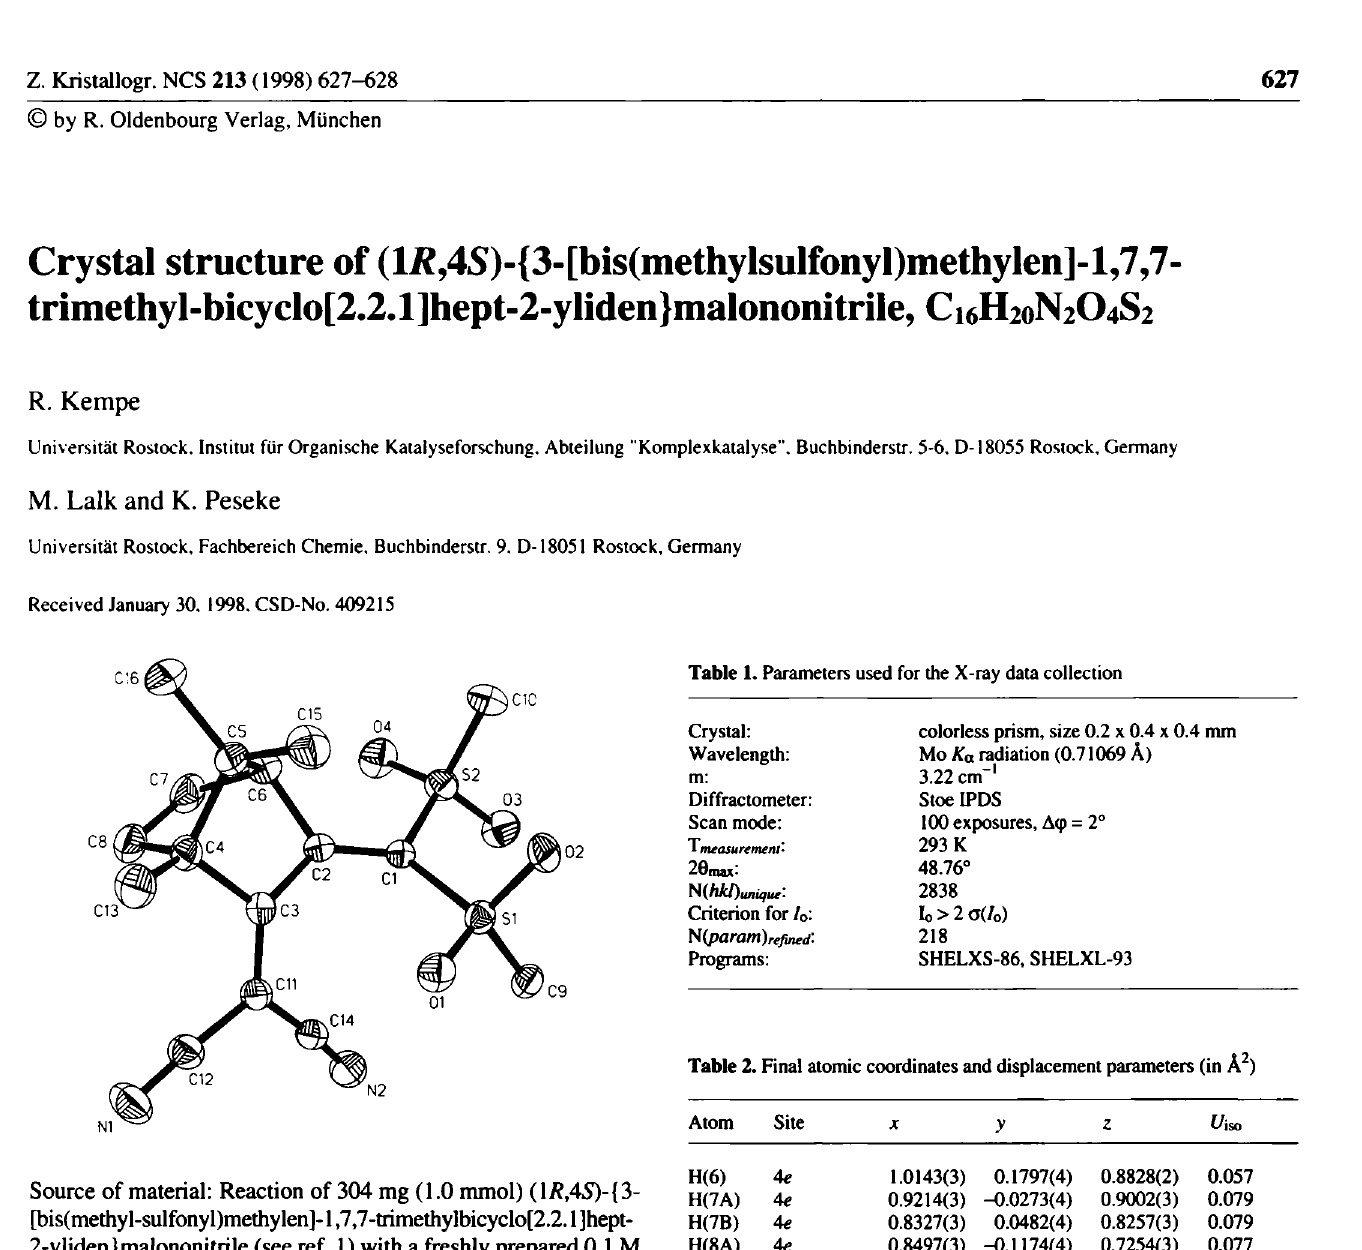
Table 2. Final atomic coordinates and displacement parameters (in Â^)